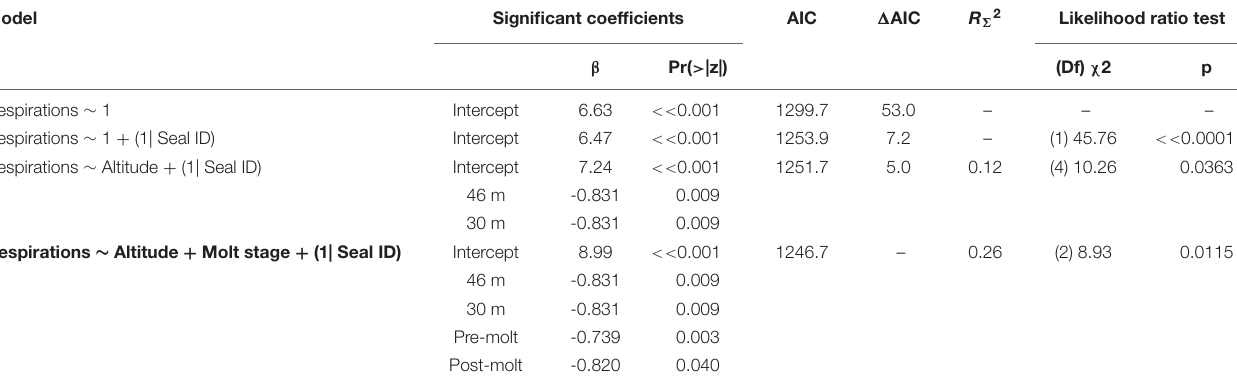
TABLE 9 | Generalized linear mixed effects model results (Poisson, link = ”log”) of respiration rates ( n = 297) from leopard seals at Cape Shirreff, Livingston Island in 2017 and